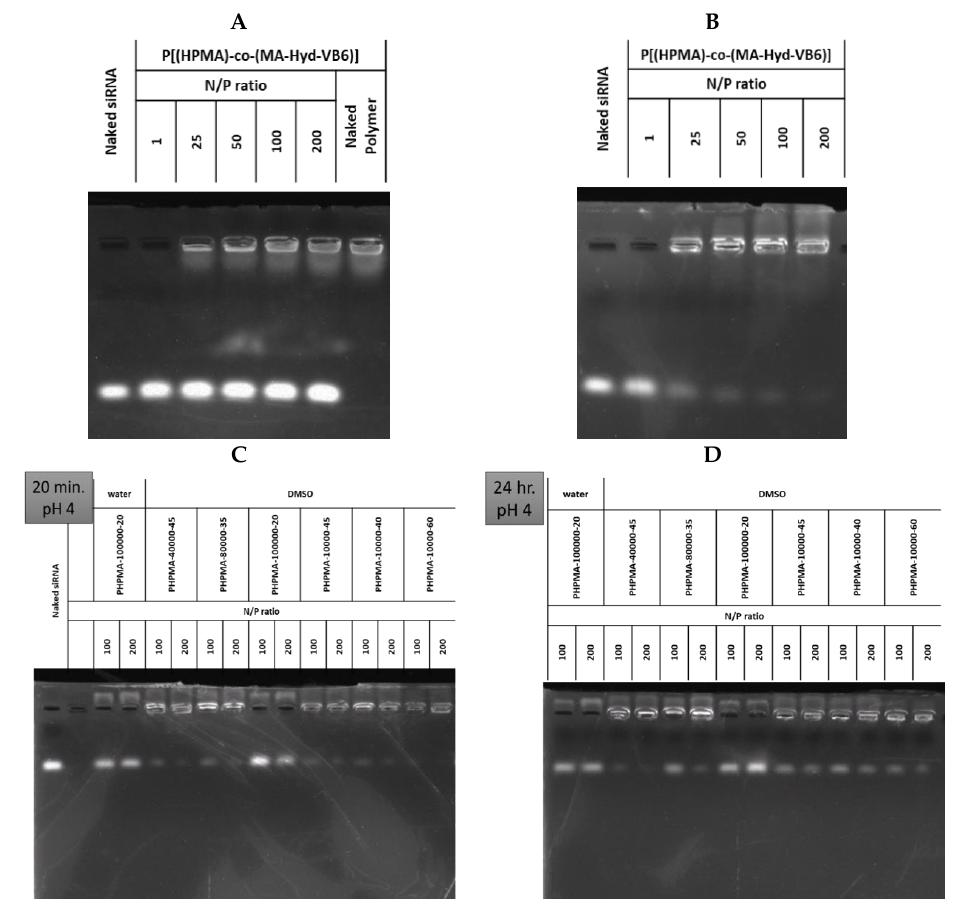
Figure 2. The absorption ability of P(HPMA-co-MA-hyd-VB6) copolymers with FAK siRNA. The northern blotting of P40K45 copolymers mixed with FAK siRNA under various nitrogen/phospho- rus (N/P) ratios at ( A ) pH 7.0 for 24 h and ( B ) pH 4.0 for 20 min. The northern blotting of copolymers with various molecular weight and VB6 contents mixed with FAK siRNA at pH 4.0 for ( C ) 20 min and ( D ) 24 h. Water: the copolymers dissolved in the DMSO/pH 7.4 PBS solution ( v / v = 1:1). DMSO: the copolymers dissolved in the DMSO/pH 4.0 300 mM citrate buffer ( v / v = 1:1). Table 2 . The characterization of LP and DLP at 25